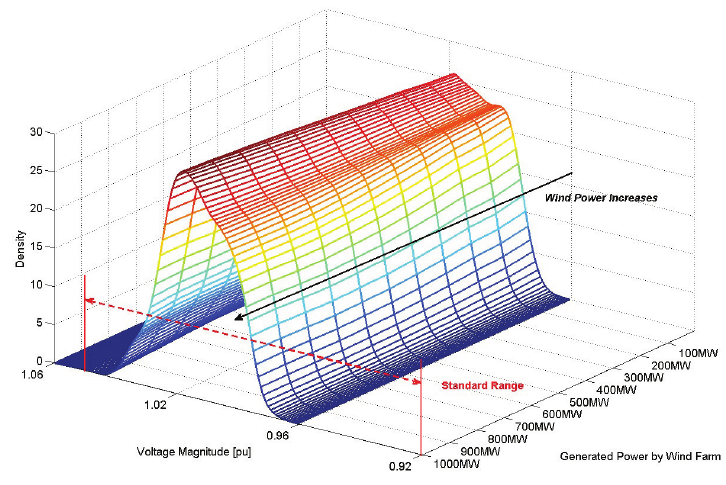
Figure 5. Wind power variability vs. probability density function of voltage regulation curve in FirstEnergy/PJM transmission system.